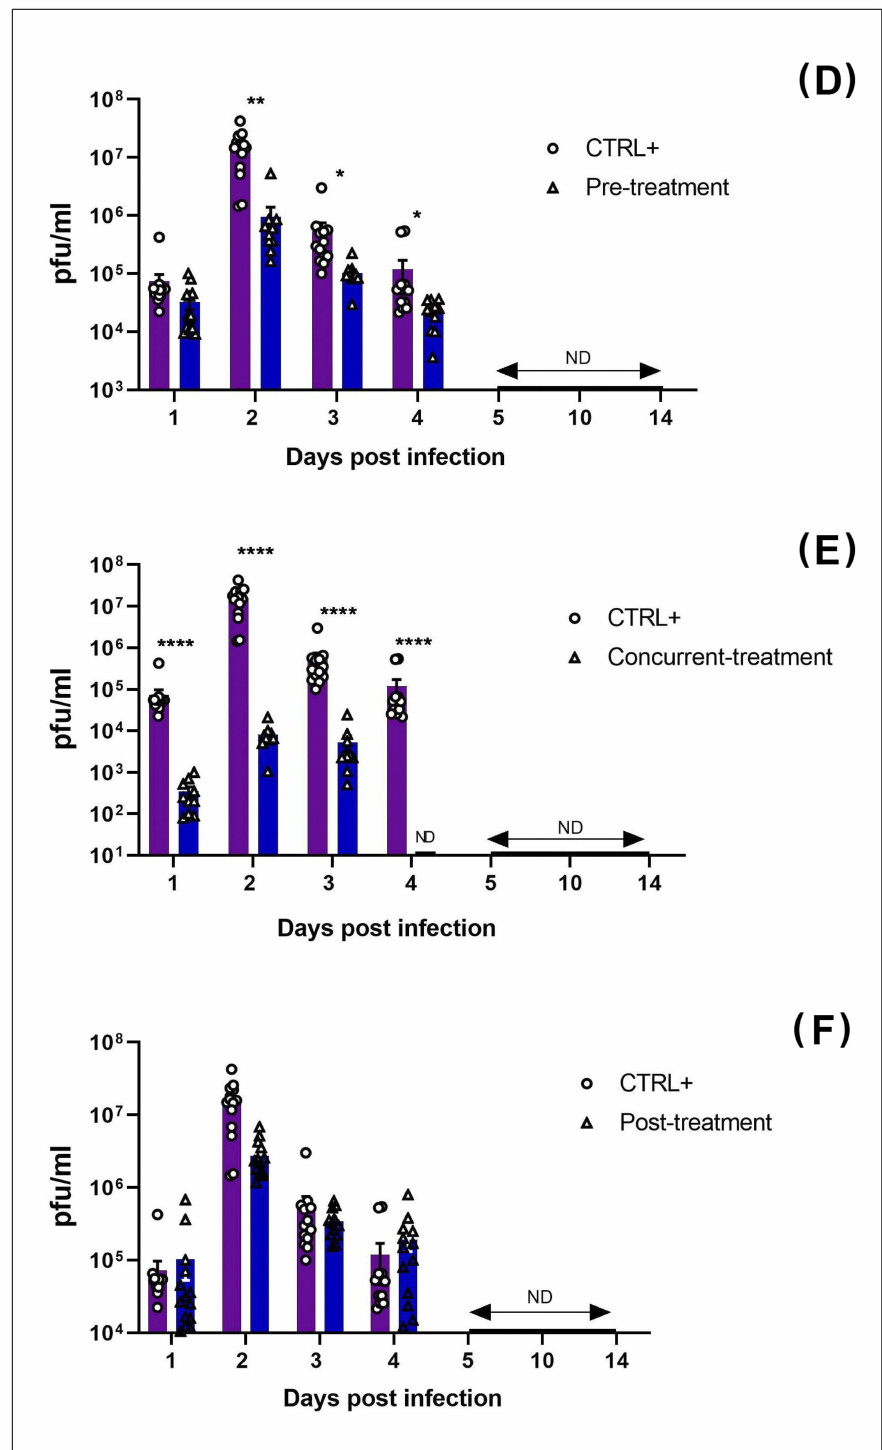
Figure 4. Favipiravir decreased MAYV yield in peripheral blood in pre- and concurrent-treatment. MAYV-infected C57BL/6 mice were orally pre-treated ( n = 16), concurrently treated ( n = 16), post-treated ( n = 16), or untreated ( n = 8) with Favipiravir 300 mg/kg once daily for 5 consecutive days. Viral RNA and infectious viral particles were quantified in peripheral blood samples using RT-qPCR ( A – C ) and plaque assay ( D – F ) at different dpi. Each point represents values of an individual mouse. ND (not detected) indicates absence of infectious viral particles in the plaque assay. The two-way ANOVA test and Turkey’s test were used; * p < 0.05; ** p < 0.01; **** p < 0.0001. Half of the mice were sacrificed at 7 dpi and the remaining animals at 14 dpi (see Figure